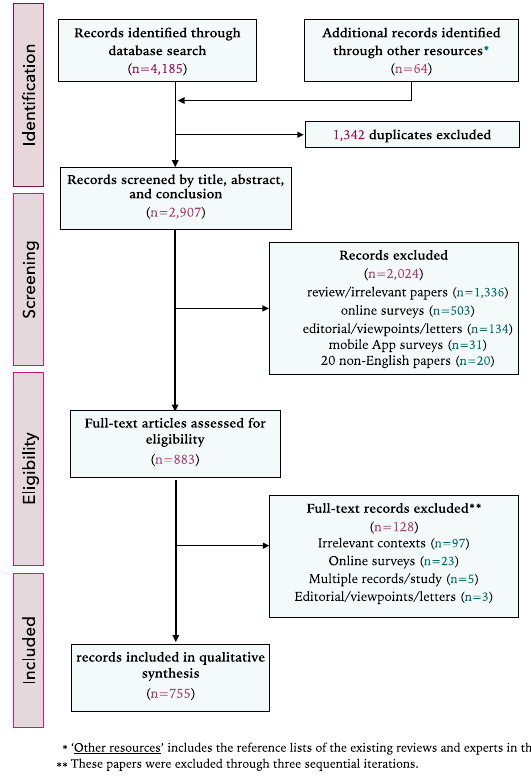
Fig. 1 Flow diagram. The overall process of article selection following PRISMA-ScR